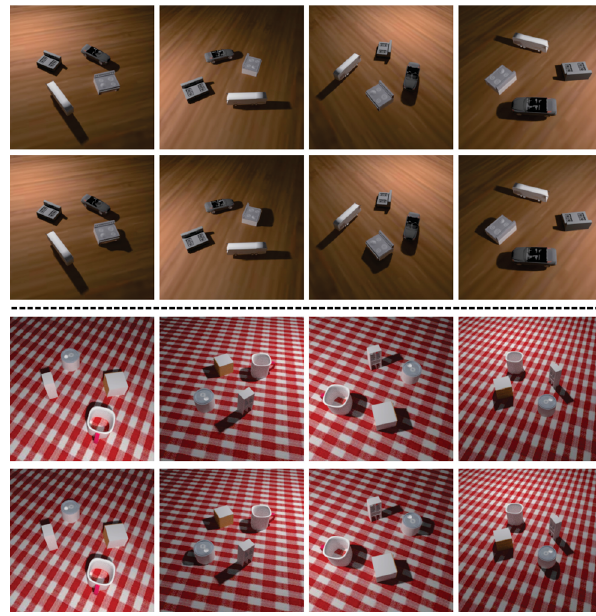
Fig. 5 Two examples of shadow synthesis for the same scene and illumination, with different viewing angles. In each example, top row: input scenes, bottom row: corresponding synthetic results.